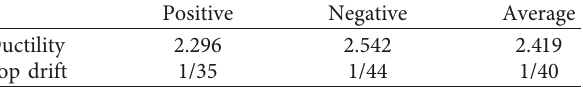
Table 4: Ductility and roof drift.